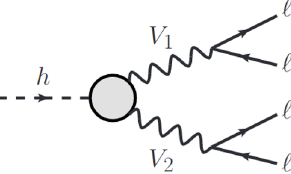
Figure 2 . Representation of the hV V corrections to the h → 4 l amplitude where V 1 , 2 = Z, γ and ‘, ‘ 0 = e, µ